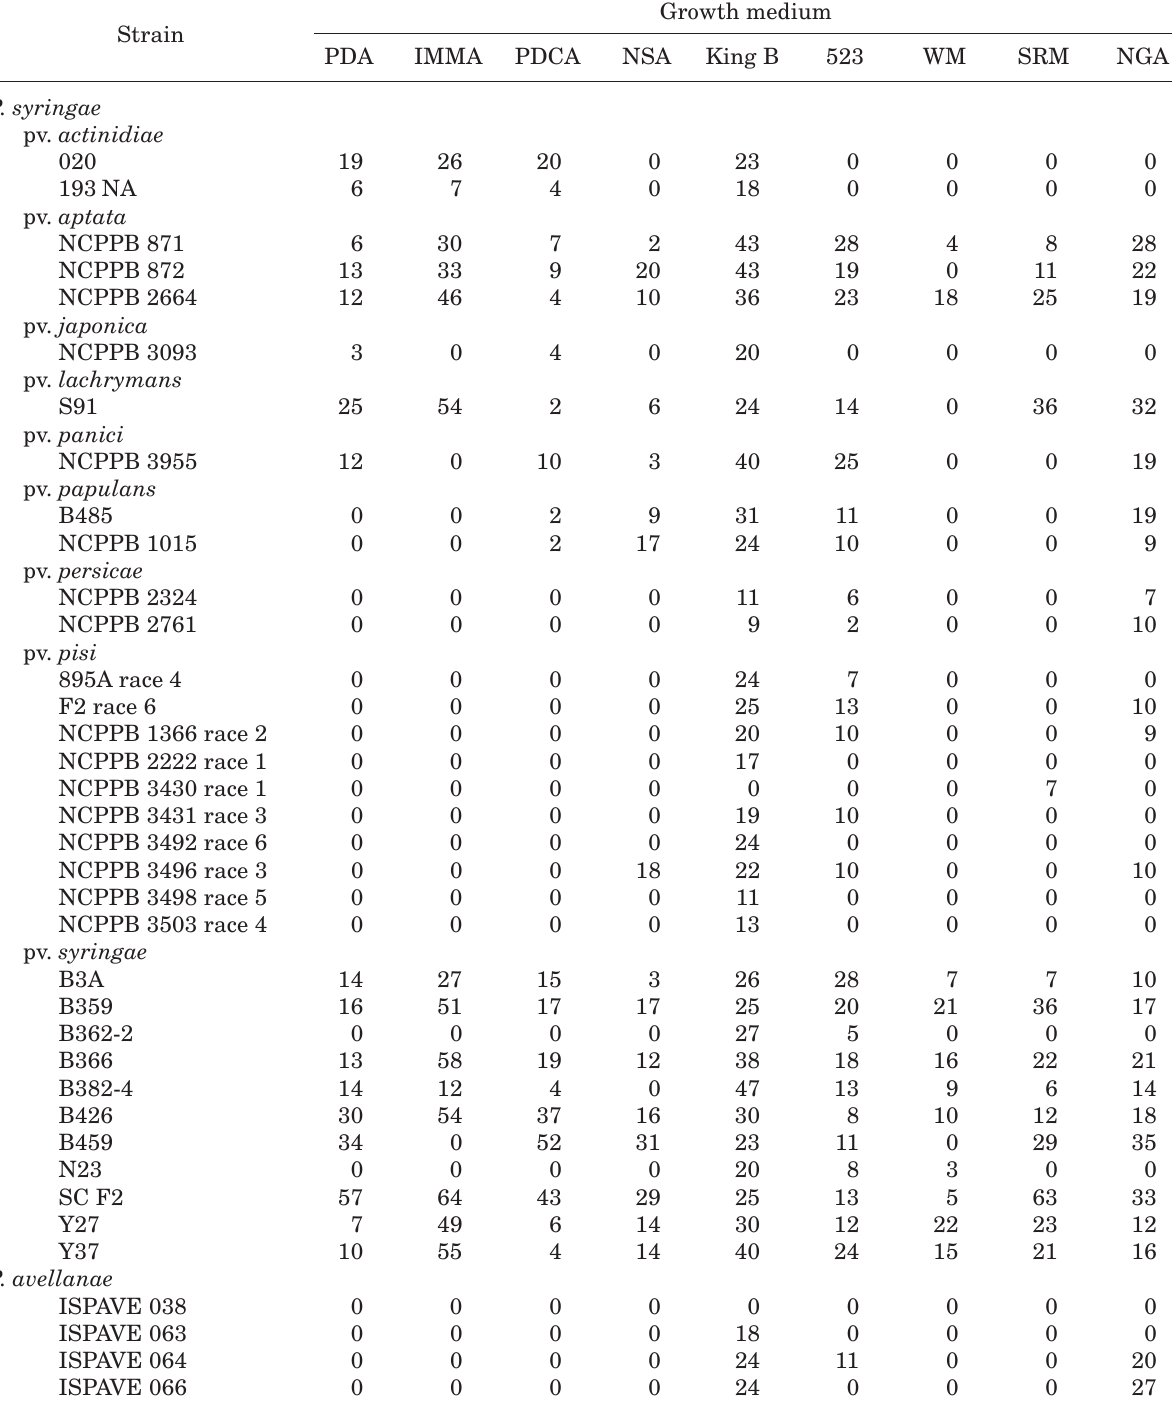
Table 3. Diameter (mm) of the inhibition zone produced by 33 strains of 9 Pseudomonas syringae pathovars and 4 strains of P . avellanae tested on 9 media for inhibition of Rhodotorula pilimanae .